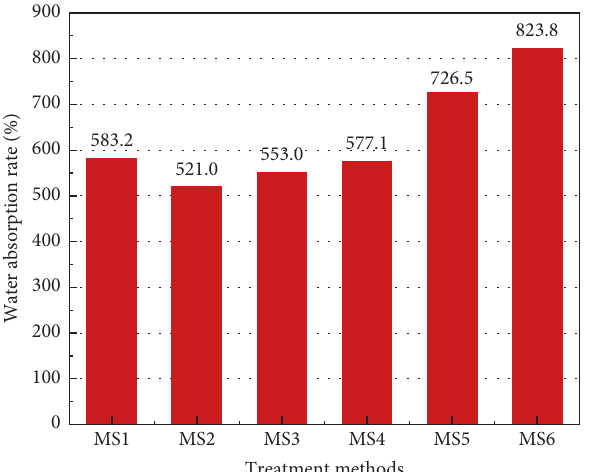
Figure 2: Test results of water absorption rate of wheat straw fibers before and after modification.